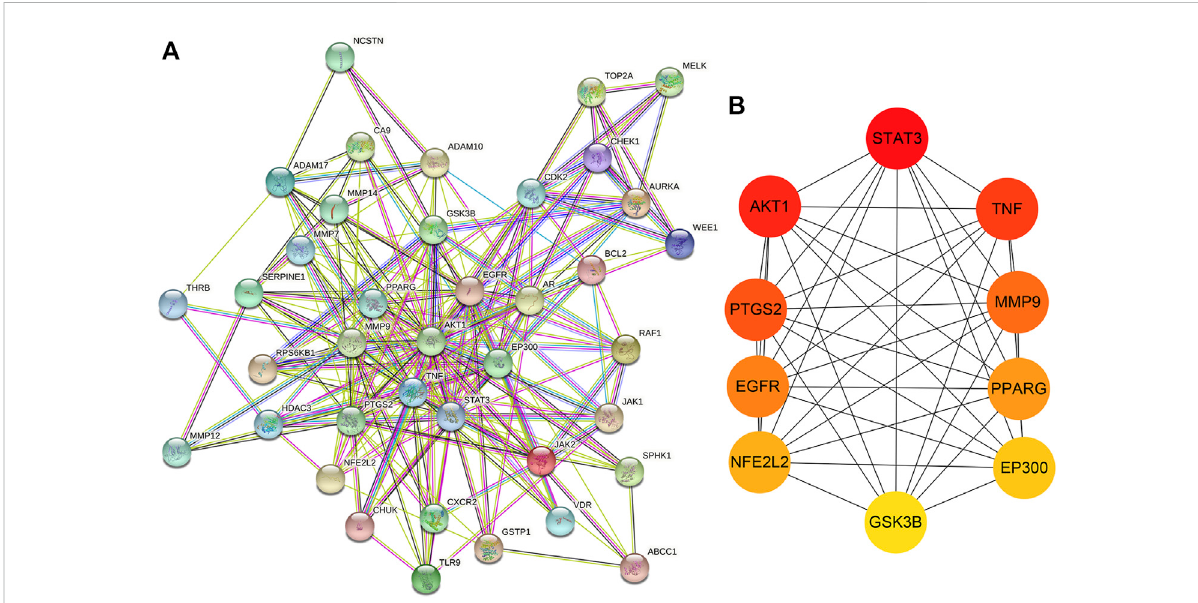
FIGURE 6 The PPI network and top 10 targets of CUR against TNBC. (A) The PPI network of potential targets of CUR against TNBC. (B) The interaction diagram of the top 10 targets of CUR against TNBC.